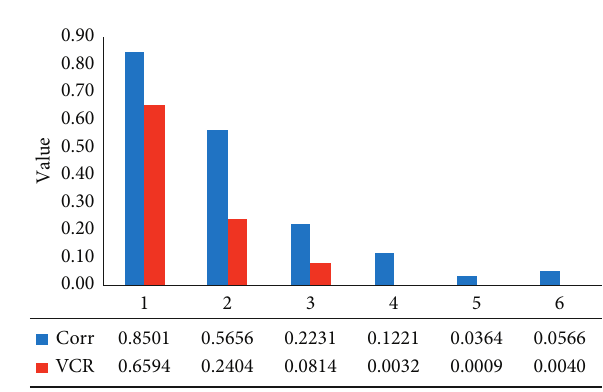
Figure 6: IMF components of the S